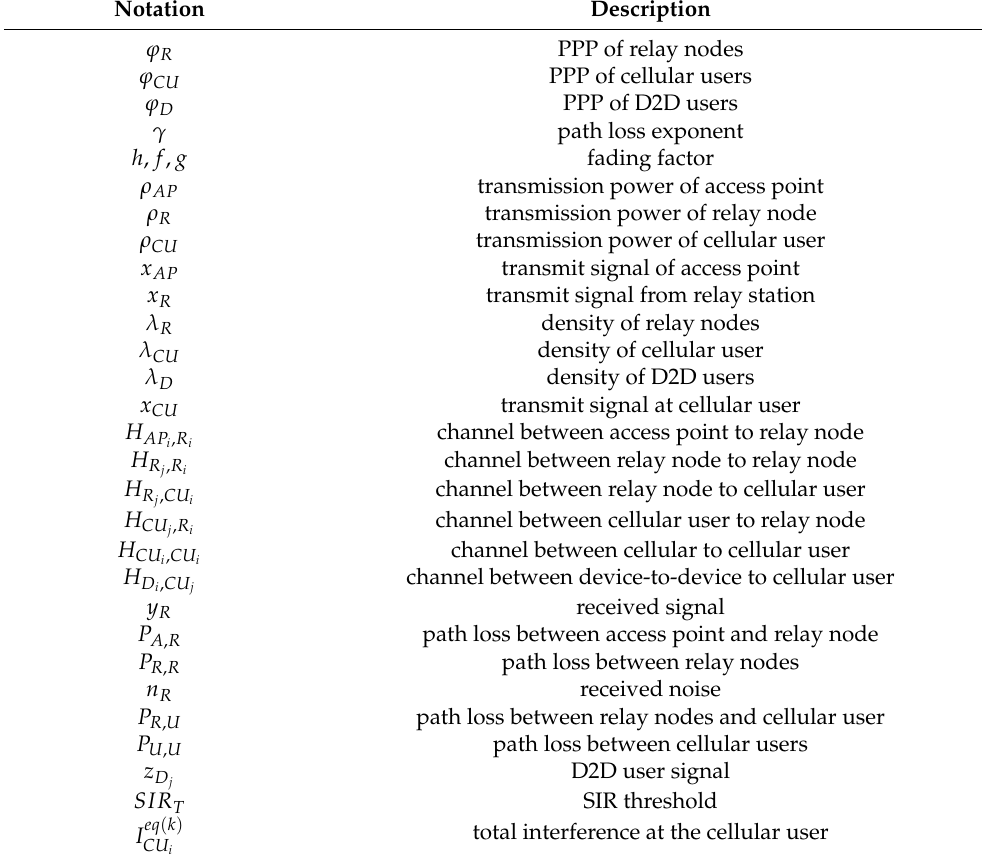
Table 1. Notations and their